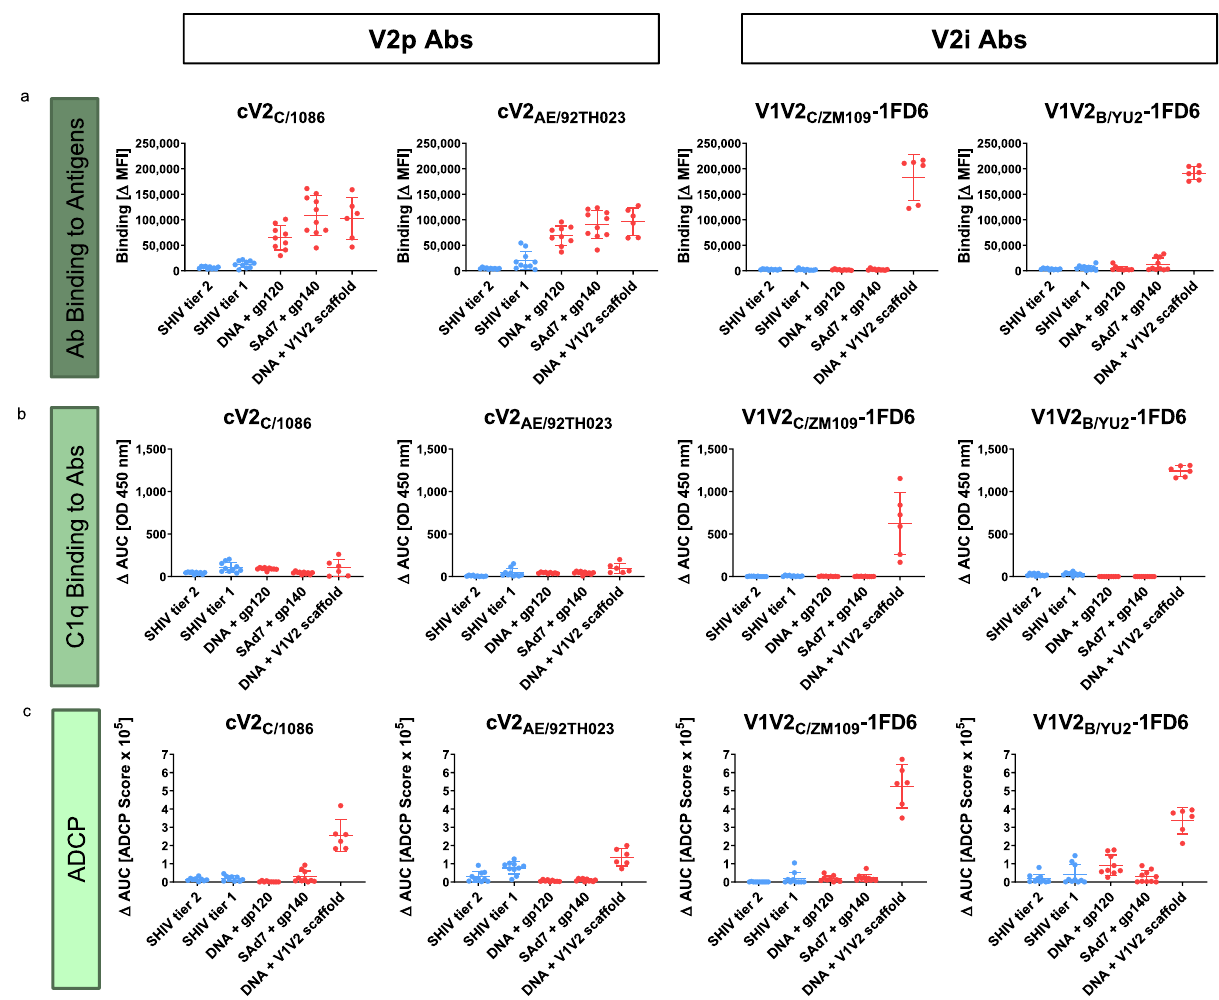
Fig. 4 Antibody binding, C1q binding, and ADCP responses of NHPs infected with SHIV (blue) ( n = 20) or immunized with one of the three immunization regimens (red) ( n = 25). Each data point is derived from a biologically independent plasma specimen. Each panel shows results from a different assay: a multiplex bead Ab binding, b C1q binding, and c ADCP. Activities were measured using cV2 peptides (reactive with V2p Abs) or V1V2- 1FD6 scaffold proteins (reactive with V2i Abs). Binding values in panel a are Δ MFI as shown in Fig. 3. Values in panels b and c represent area-under-the- curve ( Δ AUC) and were calculated for C1q from two-fold plasma titrations ranging from 1:50 – 400, and for ADCP from fi ve-fold dilutions ranging from 1:50 – 781,250 (Supplementary Fig. S6). Δ AUC values were calculated as the AUC from each NHP group 2 weeks after immunization or 11 (SHIV Tier 2) or 18 (SHIV Tier 1) weeks after infection from which the pre-bleed background response was subtracted. The mean of all animals within each group and the standard deviation are indicated. C1q titrations were performed once and ADCP experiments were performed at least twice. Source data are provided as a Source Data fi